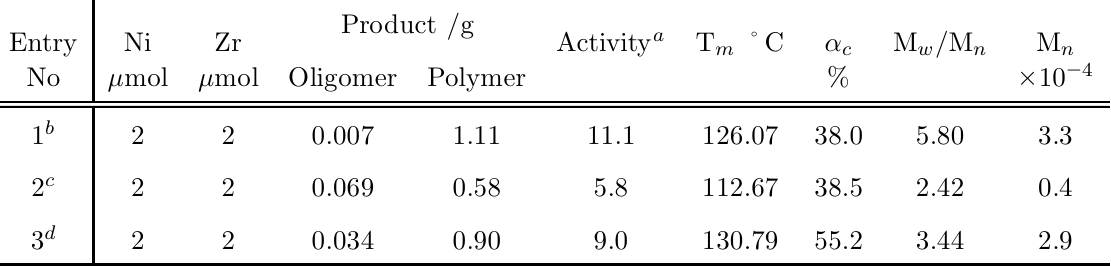
Table 1 The e¬ect of feeding order of two